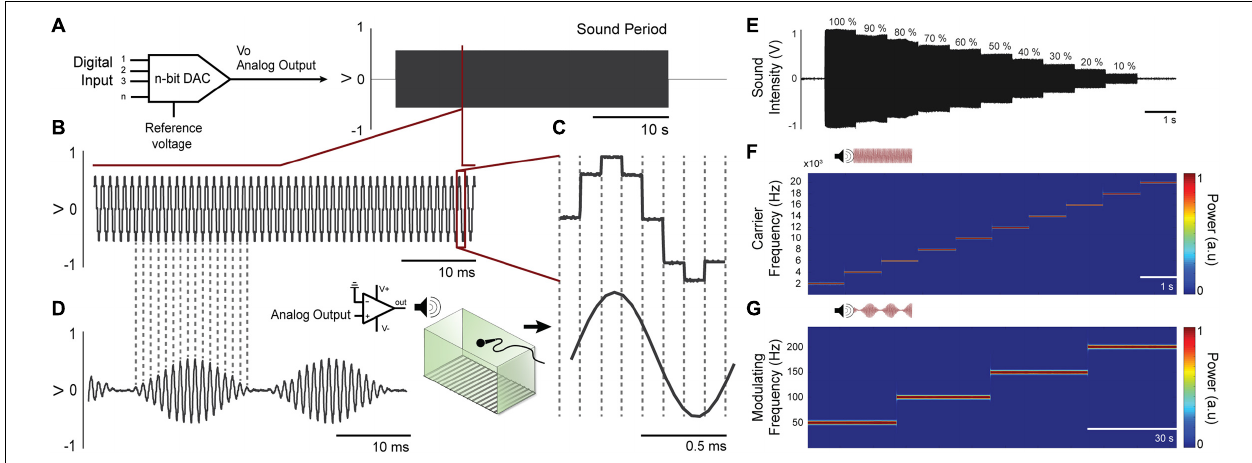
FIGURE 4 | Waveforms can be generated from digital-to-analog converter at Arduino Due. (A) A 12-bit digital-to-analog converter (DAC) is used to generate custom audio waveforms. (B) Tones with adjustable frequency can be produced with 8 voltage steps within each tone cycle. Although these voltage steps introduce undesirable high frequency components on audio signal, these components can be attenuated at power amplifier circuitry, since its frequency response is similar to a low-pass filter. (C) Upper waveform shows a single cycle generated at the DAC output, where the 8 voltage steps are visible. Lower waveform shows the same cycle measured at power amplifier output, which low-pass filter the audio signal and outputs a smooth waveform, practically a pure tone. (D) Amplitude modulation can be applied to the audio waveform, with adjustable modulating frequency. (E) The amplitude of the programed tone It can be set to various levels. (F) Time-frequency power of the carrier frequency in a range of 2–20 kHz (steps by 2 kHz) were calculated by the short-time Fourier transform-STFT demonstrating a constant amplitude over time. (G) Time-frequency power of the modulating frequency envelope in a range of 50–200 Hz (steps by 50 Hz) were calculated by the short-time Fourier transform-STFT demonstrating a constant amplitude over